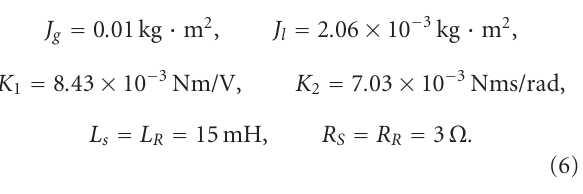
(3) and solving them numerically. The method is self- starting. Several function evaluations are required at every integration step. The fourth-order RK method needs